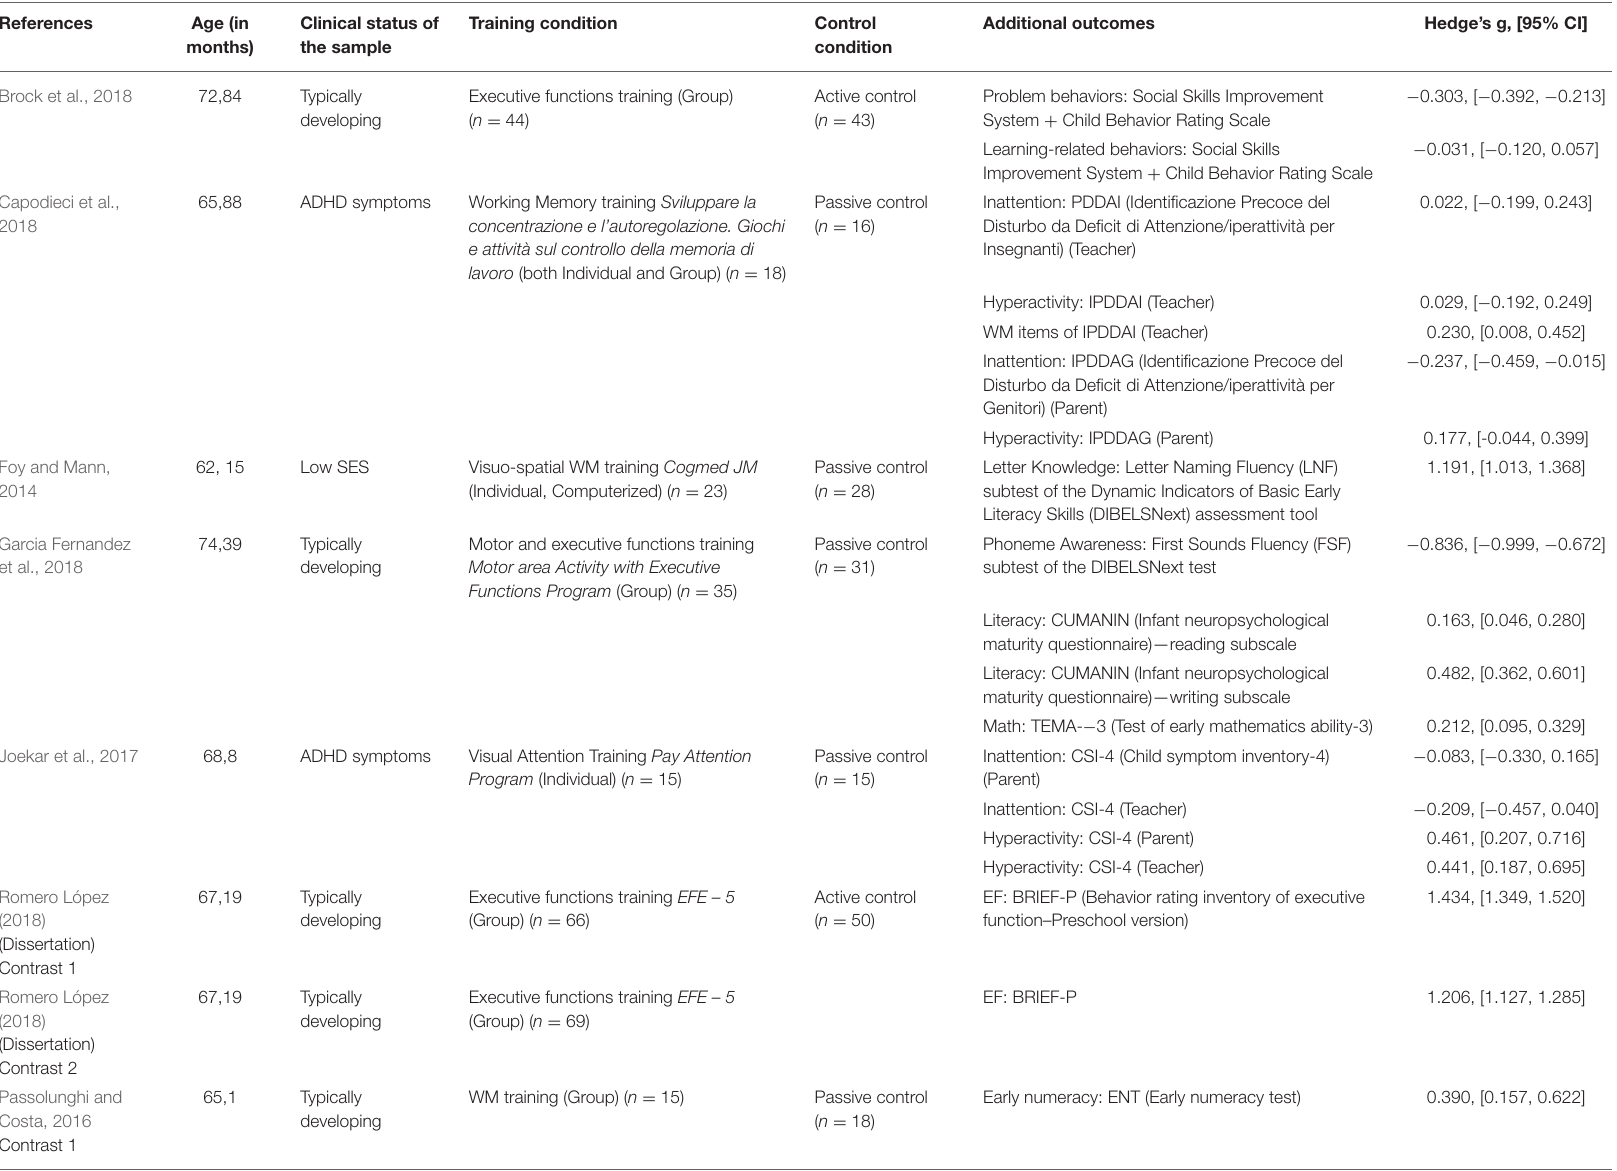
TABLE 2 | Summary of the studies included into the Meta-analysis: Addition al Outcome